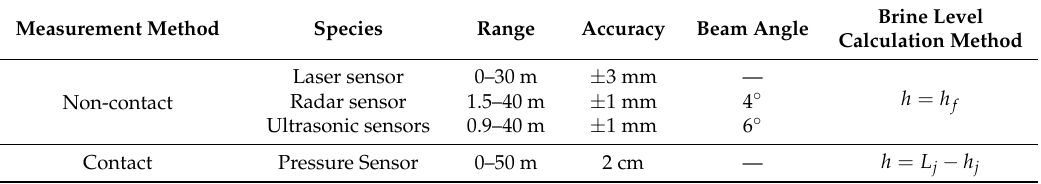
Table 4. Contact and non-contact liquid level